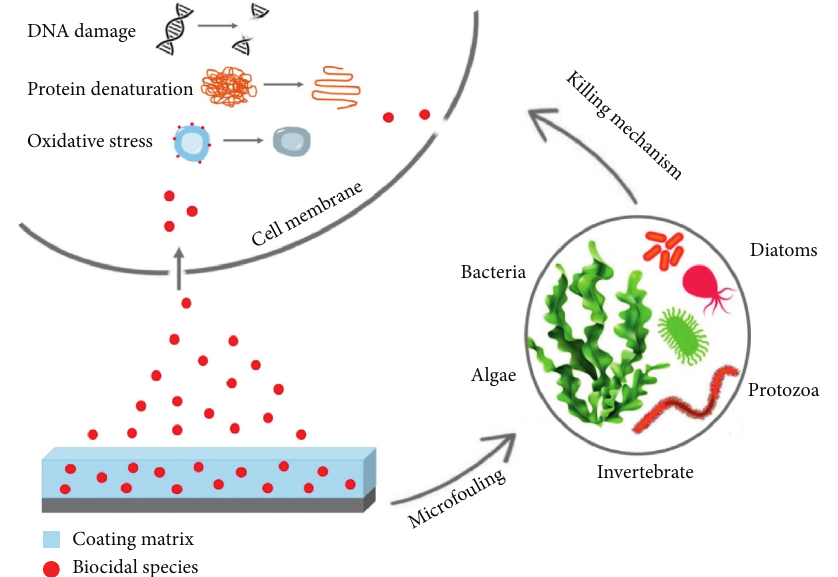
Figure 2: Schematic representation of the antifouling mechanism of paints.